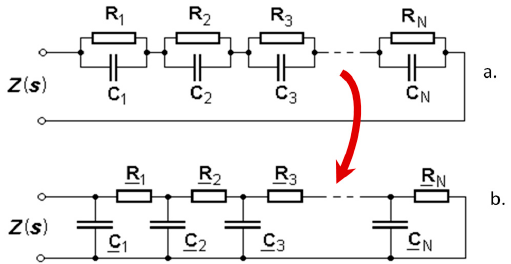
Figure 8. Foster ( a ) and Cauer ( b )-type representations of a 3D thermal RC net (from [11]).